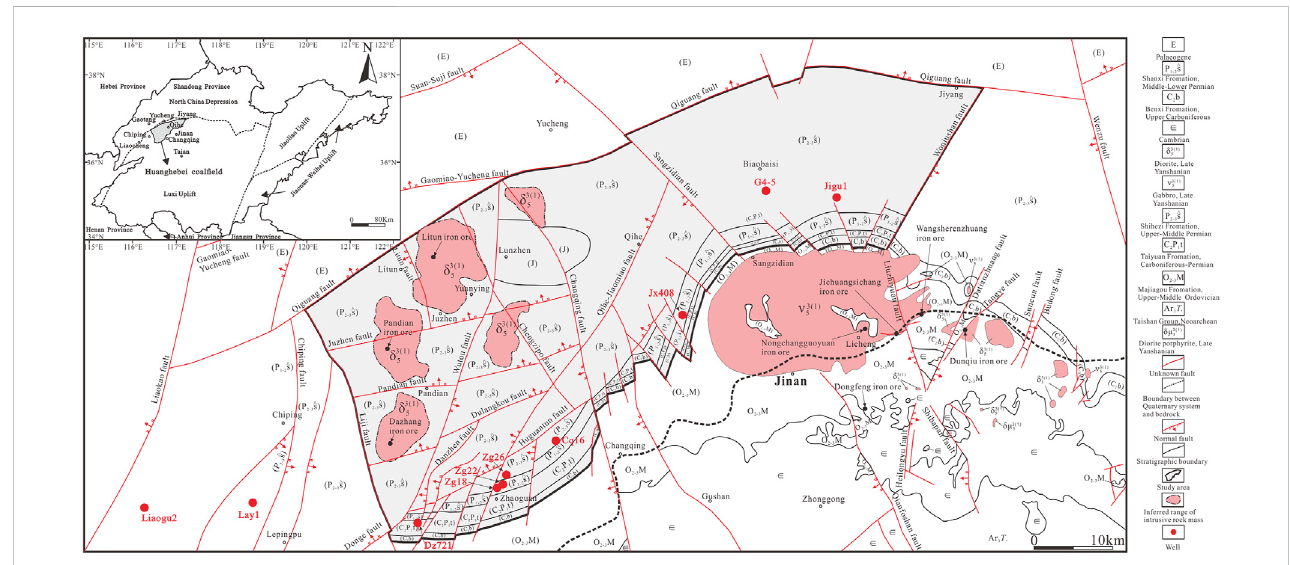
FIGURE 1 Geological map of the pre-Neogene bedrock in the study area. The area north of the dotted line at the lower right is the Quaternary coverage area. The overview map at the upper left shows the location of the study area, and the gray area within the black line denotes the Huanghebei Coal fi